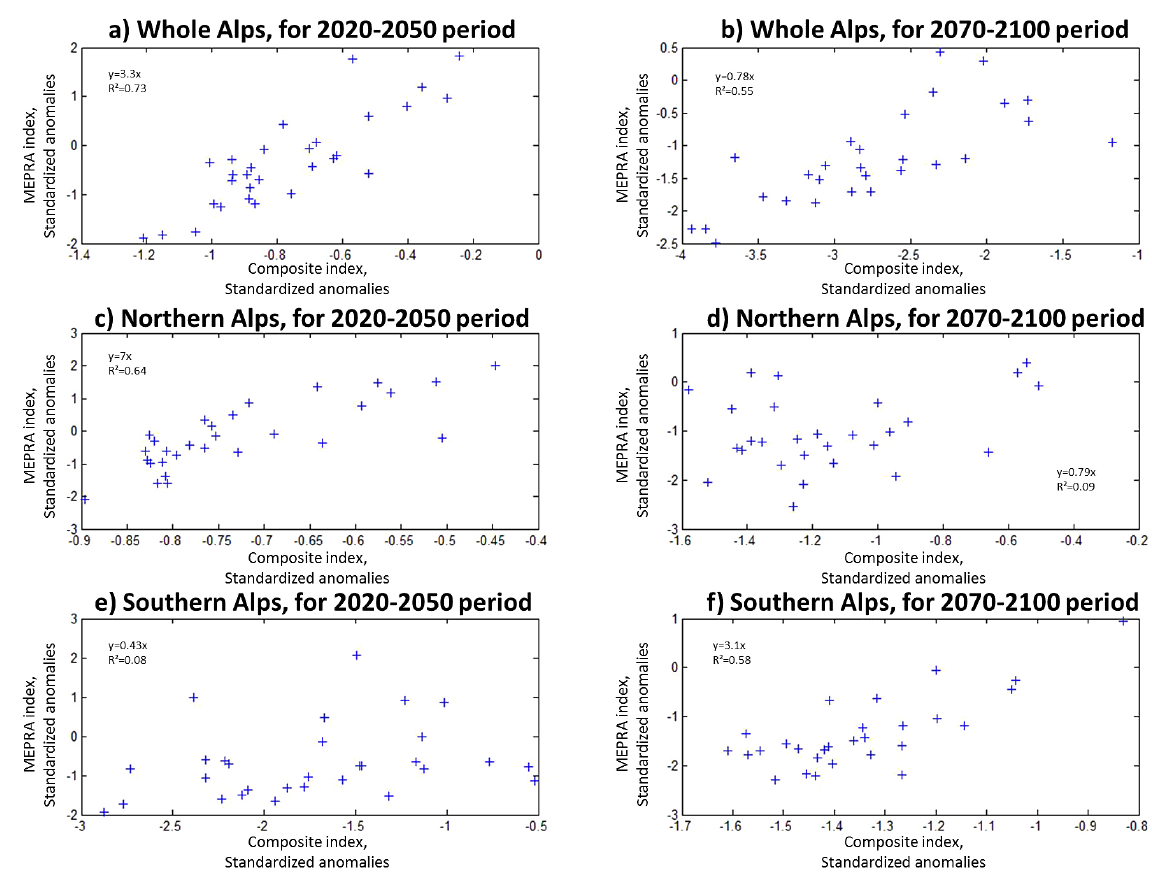
Figure 11. Scatter plots of standardized changes (as compared to reference period) in the MEPRA index vs. the CI regression model. The future periods 2020–2050 and 2070–2100 are, respectively, considered in the left and right panels. Subplots (a) and (b) concern the whole French Alps, (c) and (d) the northern French Alps and (e) and (f) the southern French